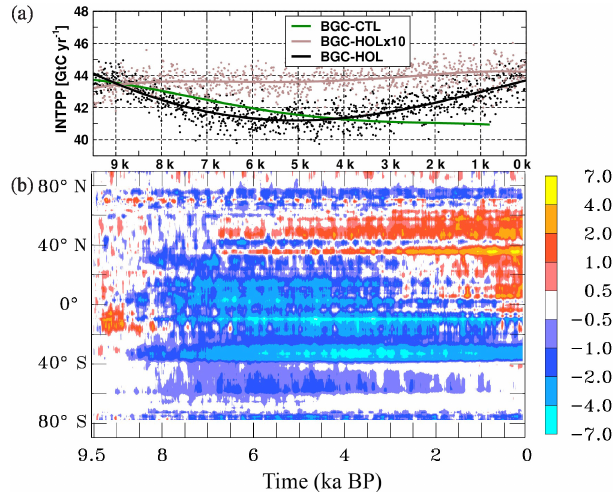
Figure 9. As Fig. 2 but (a) for time series of global primary pro- duction integrated over the upper 100m in GtCyr − 1 (INTPP), and (b) Hovmöller diagram of the changes in zonal and annual mean INTPP in mol Cm − 2 s − 1 × 10 8